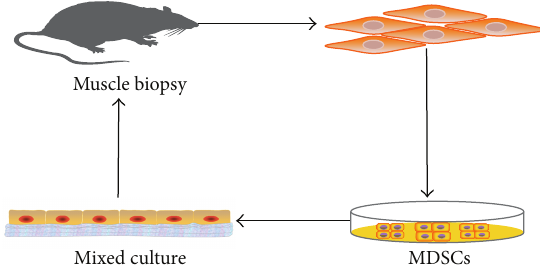
Figure 2: The model of MDSC/SIS Sling therapy for SUI (from [34]). MDSCs were firstly obtained from gastrocnemius muscle and subsequently seeded on a SIS scaffold. The MDSC/SIS Sling was cocultured for 2 weeks in vitro. Finally, the tissue-engineered suburethral sling was placed to repair a damaged urethral sphincter of SUI rat model via a midline transabdominal